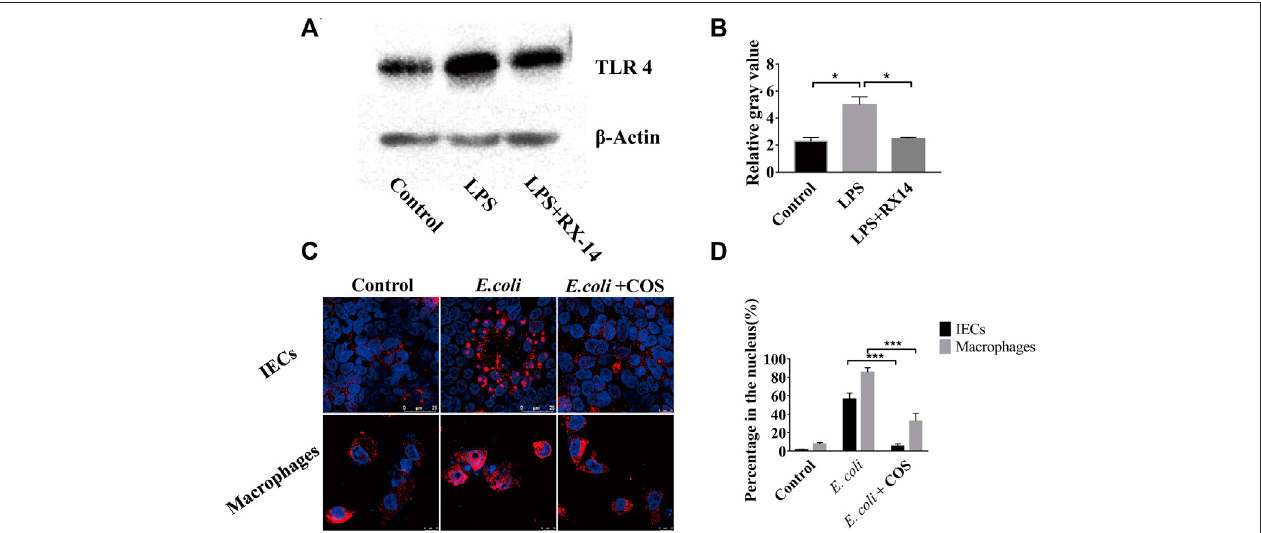
FIGURE6| RegulatoryeffectofCOSonNF- κ B(p65)signalingpathwayinenteritisonachip. (A) TheexpressionofTLR4detectedbyWesternblot. (B) Therelative gray value of TLR4. (C) Immuno fl uorescence staining against NF- κ B (p65) (Red). (D) The binding rate of NF- κ B (p65) protein to nuclear DNA. Data were represented as mean ± SD ( n = 3); One-way ANOVA test was performed, * p < 0.05, *** p < 0.001.